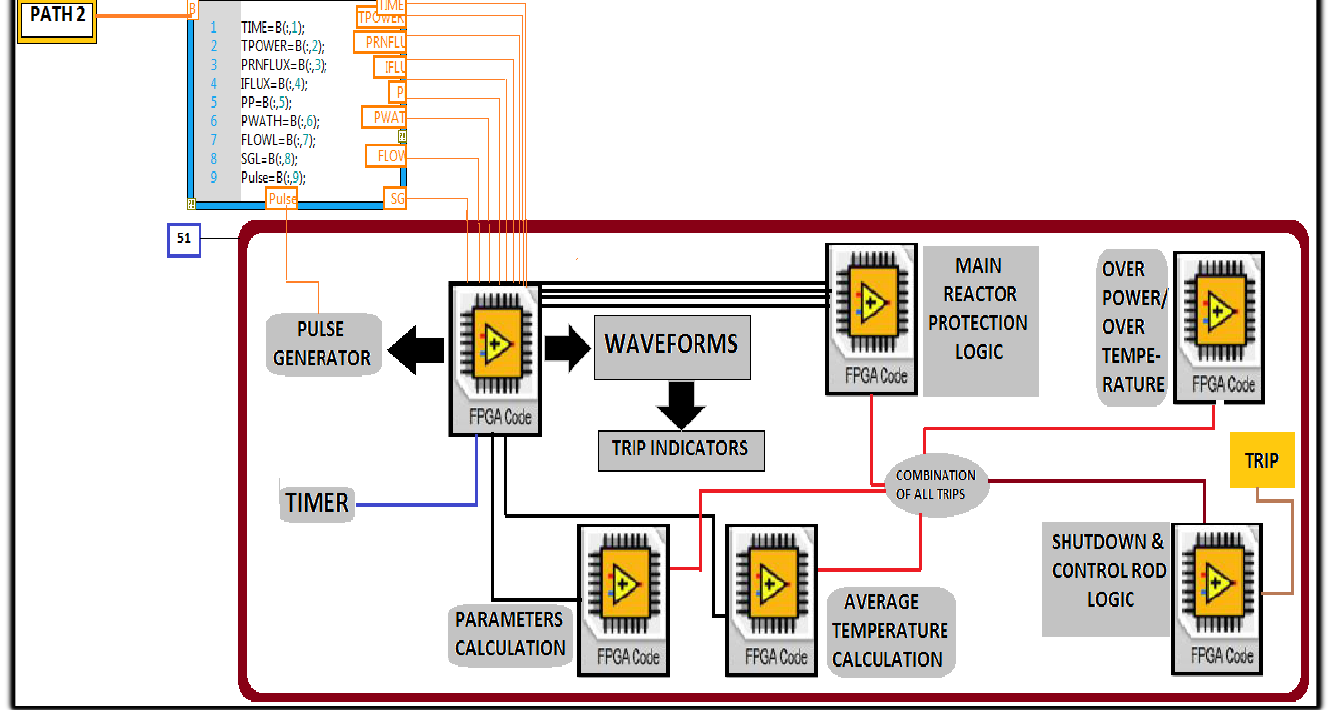
Fig. 7. ACP1000 FPGA design of RPS controllers in LabVIEW